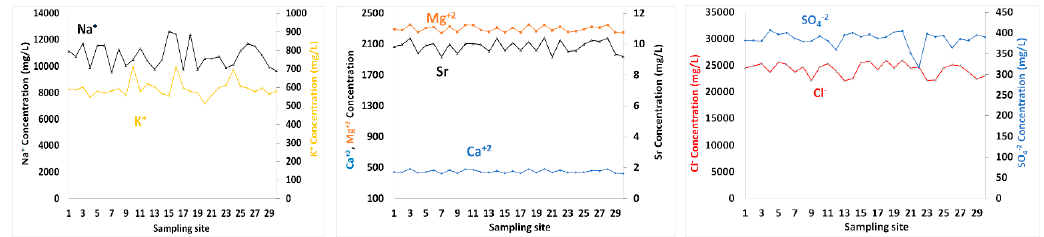
Figure 4. The spatial distributions of Na + , K + , Mg +2 , Sr, Ca +2 , SO 4 − 2 and Cl − concentrations in surface seawater of GoA, Jordan.